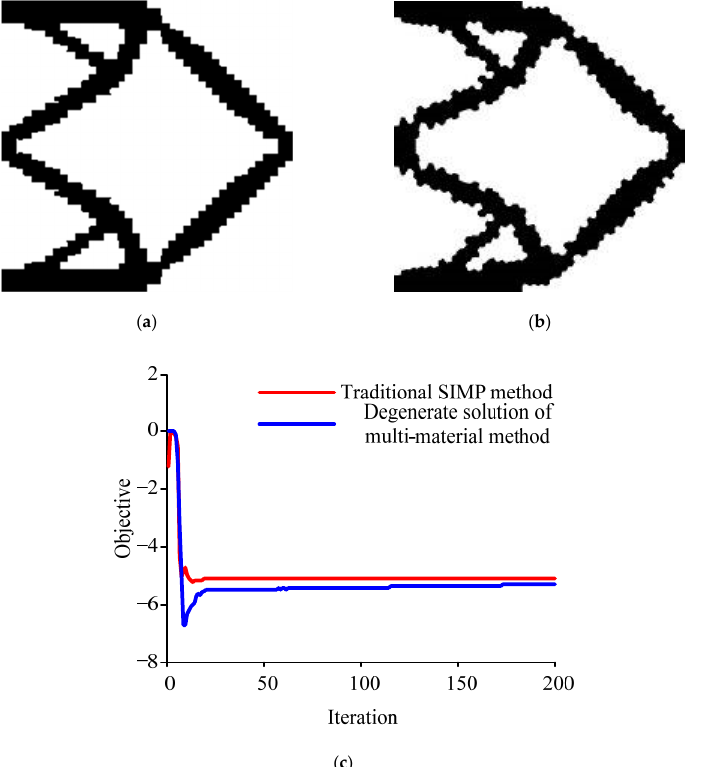
Figure 5. Optimization results: ( a ) Traditional SIMP method topologies; ( b ) degenerate solution of multi-material method (case 1); ( c ) convergence plot. Table 2. Maximum displacement at the output port of inverter.